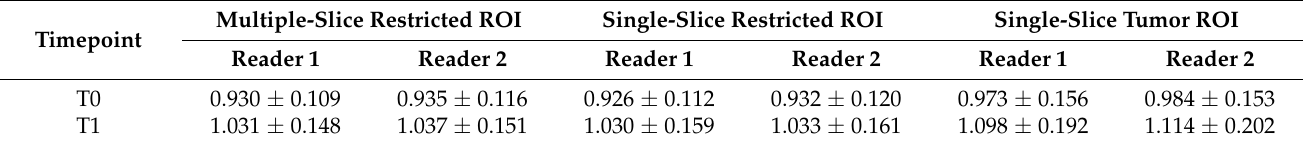
Table 3. Mean tumor ADC measured by two readers for each ROI type (unit: ×10 − 3 mm 2 /s).